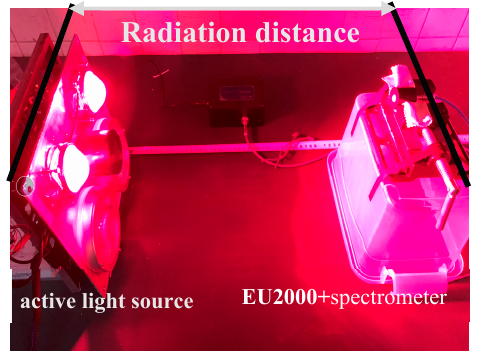
Figure 5. Spectral attenuation test site.